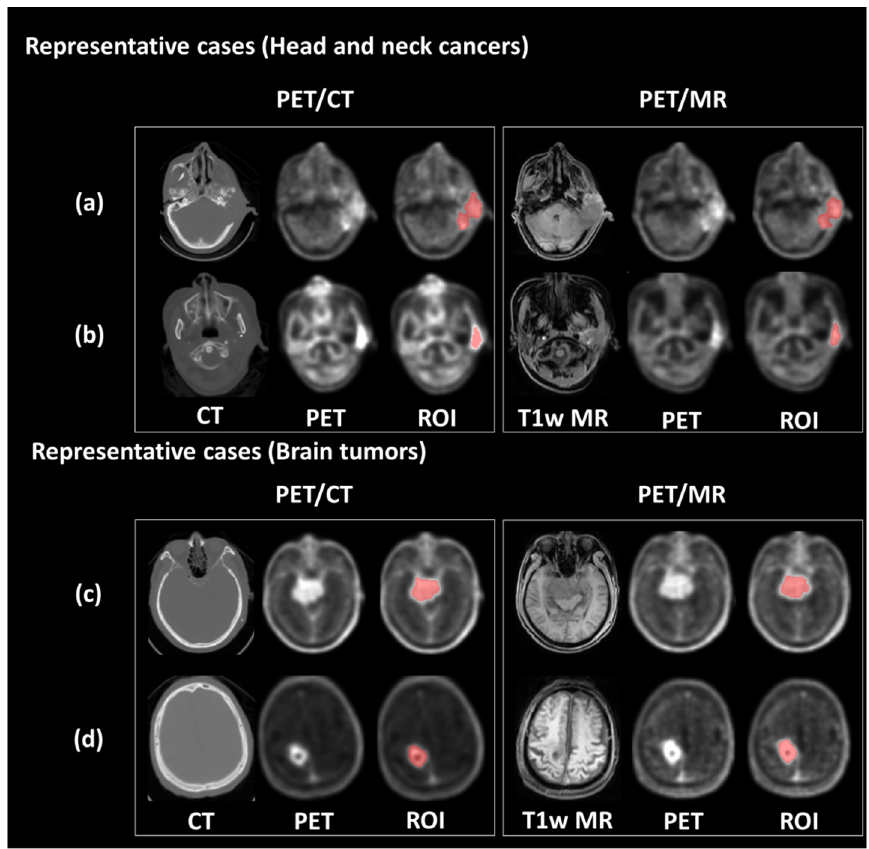
Figure 1. Representative PET/CT and PET/MR images. The upper panel shows the PET images and tumor contour of patients with ear sarcoma ( a ) and tongue cancer ( b ), respectively. The bottom panel shows the PET images and tumor contour of patients with meningioma ( c ) and glioblastoma ( d ), respectively.